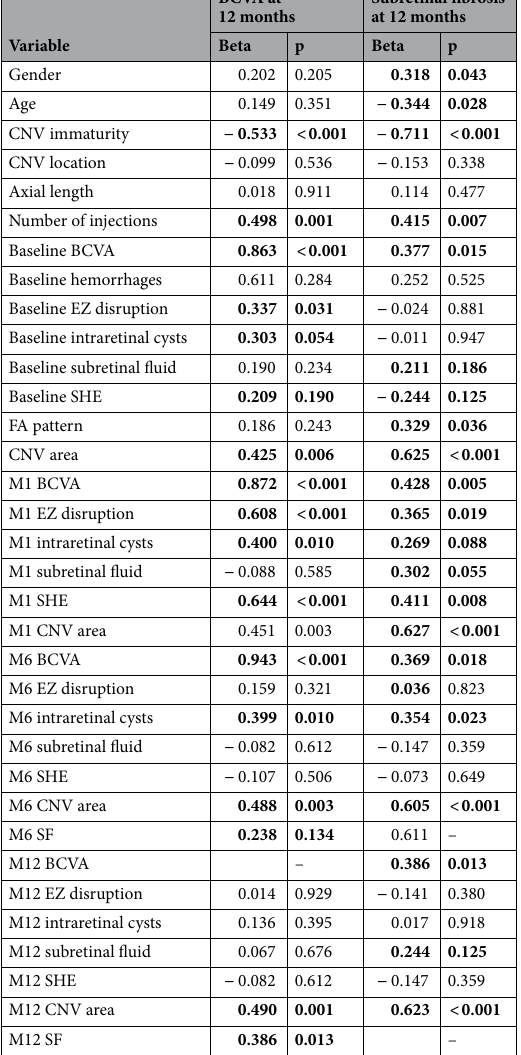
Table 5. Results of univariate regression analysis for BCVA at 12 months and Subretinal Fibrosis occurrence at 12 months as dependent variables. Significant values are in bold. Variables with a p value < 0.2 were included in the multivariate regression analysis. BCVA Best-Corrected Visual Acuity, CNV choroidal neovascularization, SF subretinal fibrosis, FA fluorescein angiography, SHE subretinal hyperreflective exudation, EZ ellipsoid zone,